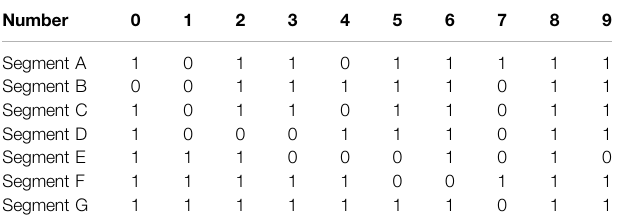
TABLE 1 | Digital characteristics of the digital display